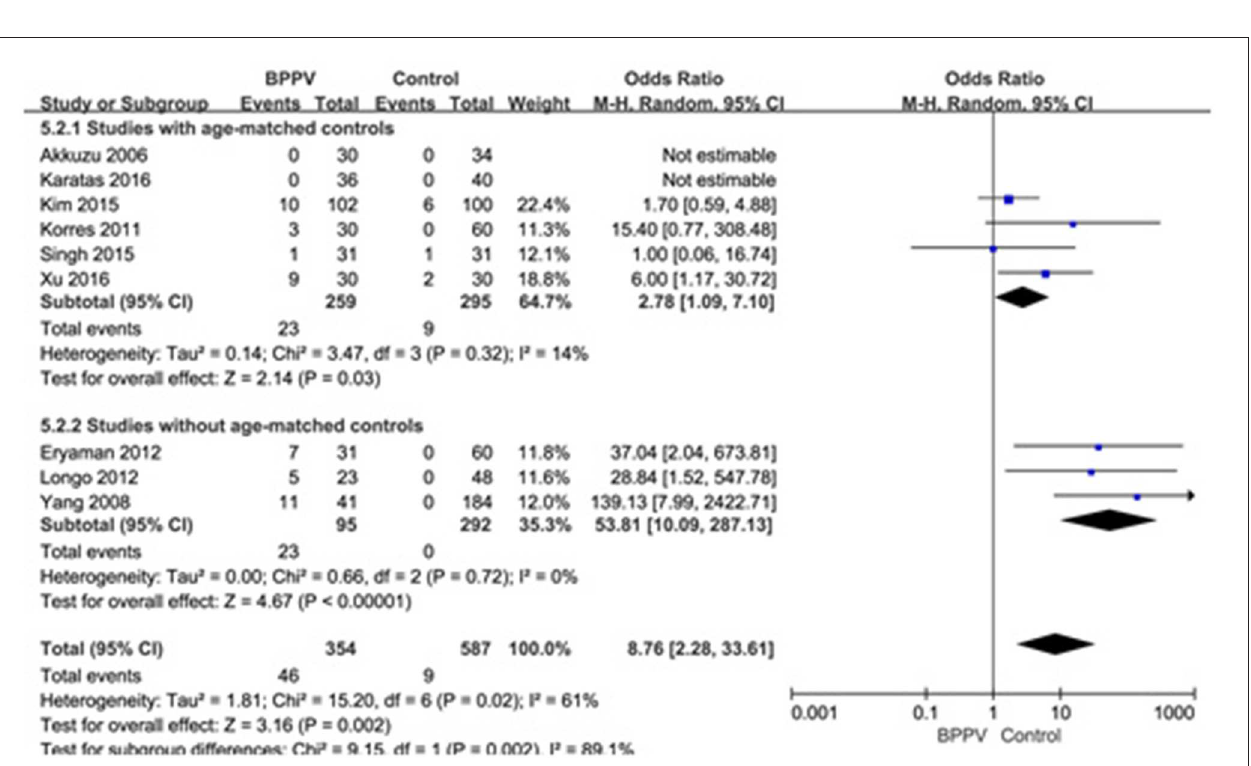
FIGURE 6 | Forest plots of subgroup meta-analysis of proportion of absent response of cVEMP based on whether or not the age matches between BPPV and healthy groups. BPPV, benign paroxysmal positional vertigo; cVEMP, cervical vestibular evoked myogenic potential.